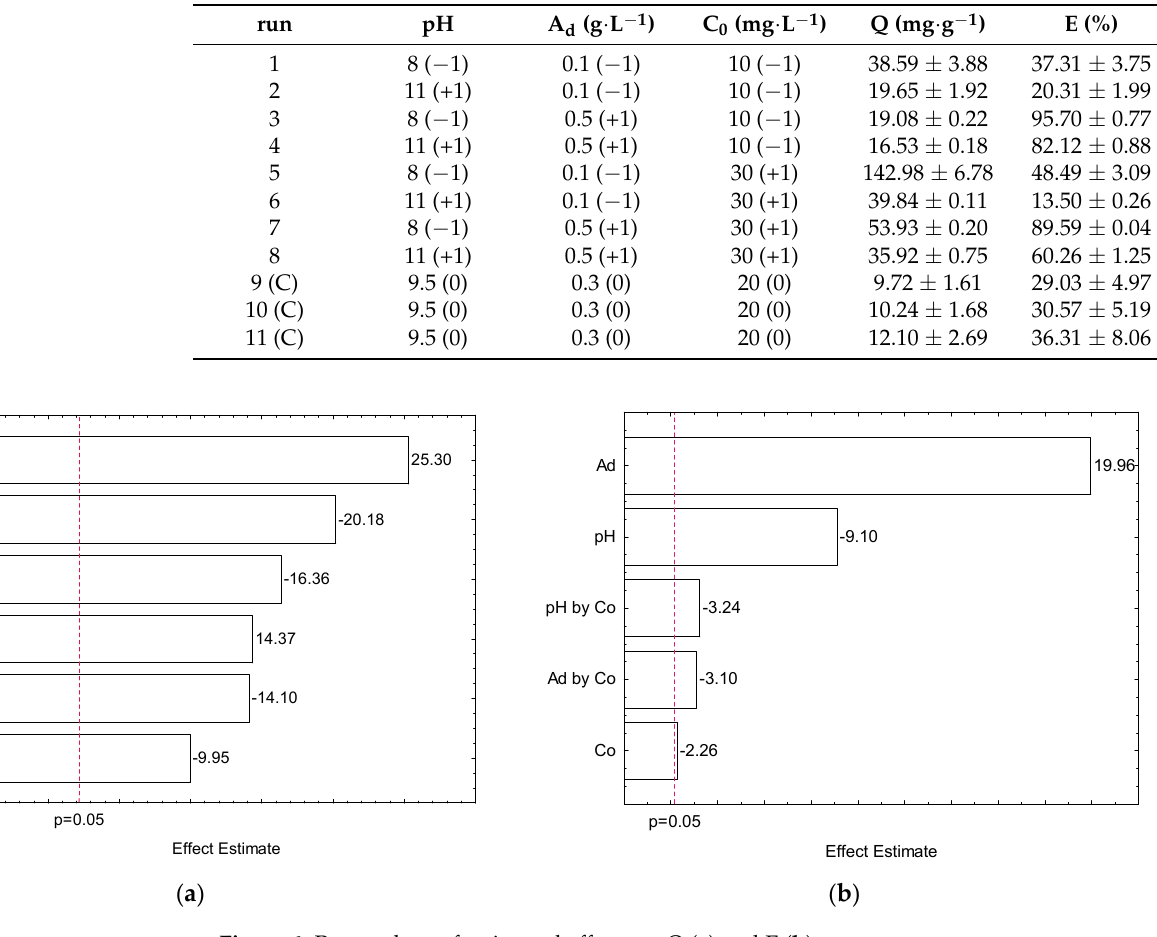
Figure 6. Pareto chart of estimated effects on Q ( a ) and E ( b ).